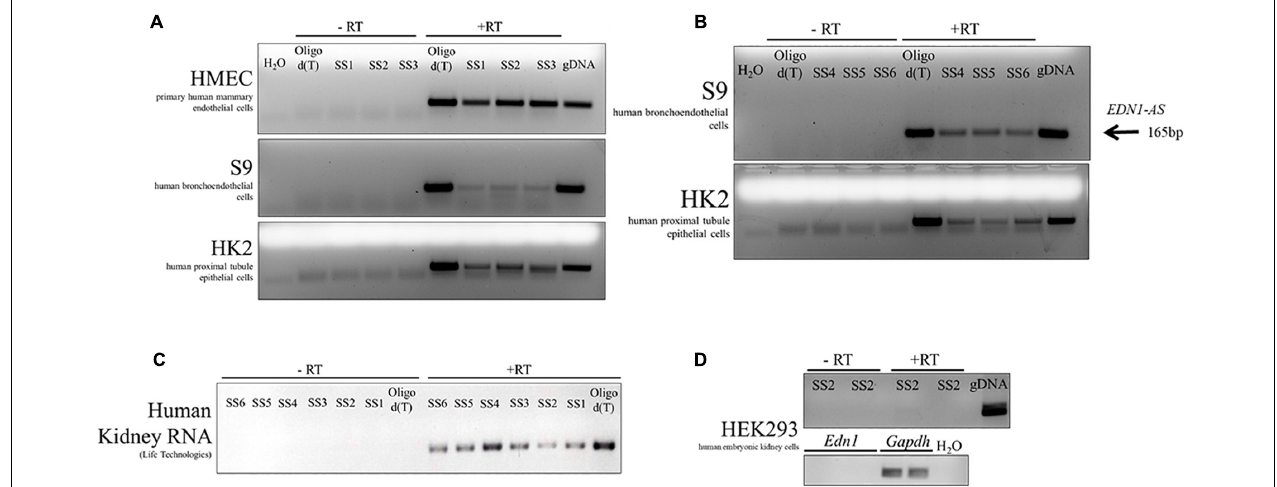
FIGURE 4 | Identification of EDN1-AS in Human Cell Culture Models and Human Kidney RNA. Strand-specific reactions were used to test various human cell culture models for the presence of an antisense transcript originating from the predicted promoter region. This transcript has been named EDN1-AS. Strand-specific RT primers SS1-3 were used to test for an antisense transcript in primary human mammary endothelial cells (HMEC), human bronchoendothelial cells (S9), and in human proximal tubule epithelial cells (HK2) (A) . Oligo dT primers were used as a positive control for the RT reactions. For each PCR reaction, water was used as a negative control and gDNA as a PCR positive control. For each of the strand-specific reactions, a no RT (-RT) control reaction was ran with the same cDNA sample. Strand-specific RT reactions using primers further away from the predicted promoter site (SS4–SS6) were designed to determine if the transcript spanned the entire length of the EDN1 gene using available samples from S9 and HK2 cells (B) . All strand-specific RT primers (SS1–SS6) were used to determine if EDN1-AS could be detected in human kidney tissue RNA samples from Life Technologies (C) . EDN1-AS and EDN1 transcripts could not be identified in human embryonic kidney cells (HEK293) (D) . All gels are representative of at least n = 2 per cell line.